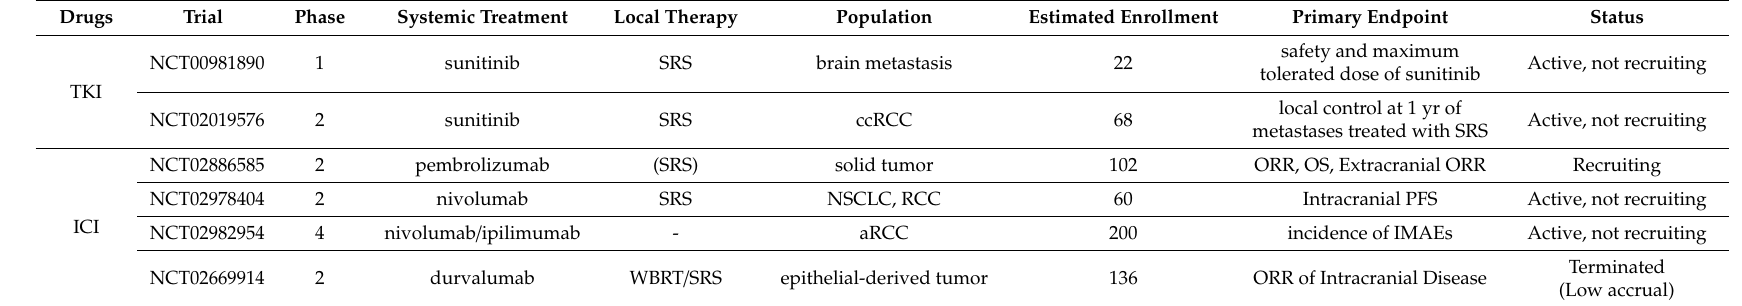
Table 2. Summary of the ongoing trials of TKI or ICI in brain metastases of